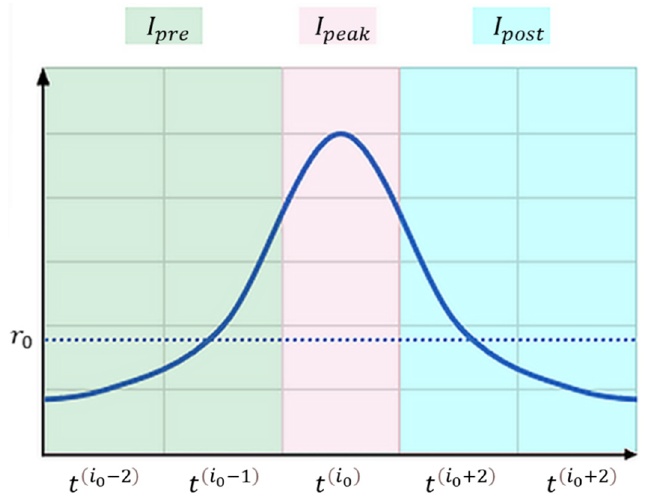
Figure 3. Example of the multiple stages of heavy rain.